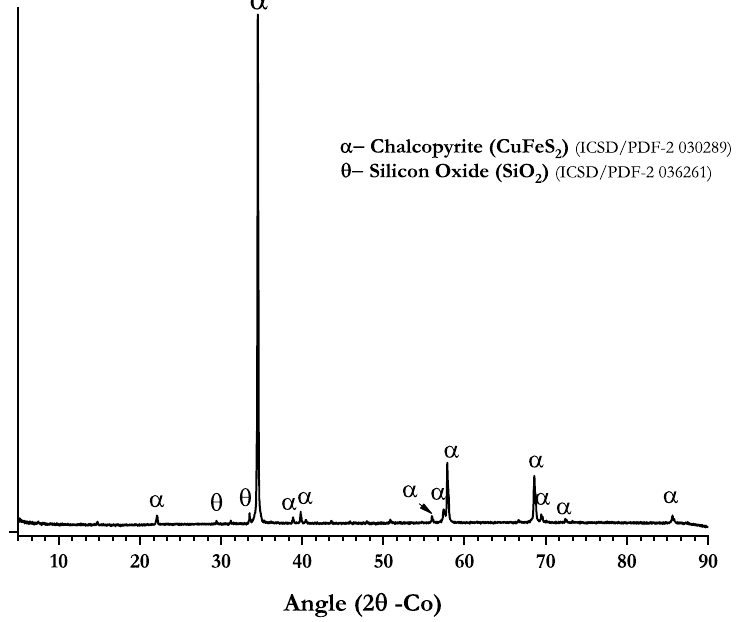
Figure 3. X-ray diffractogram of chalcopyrite